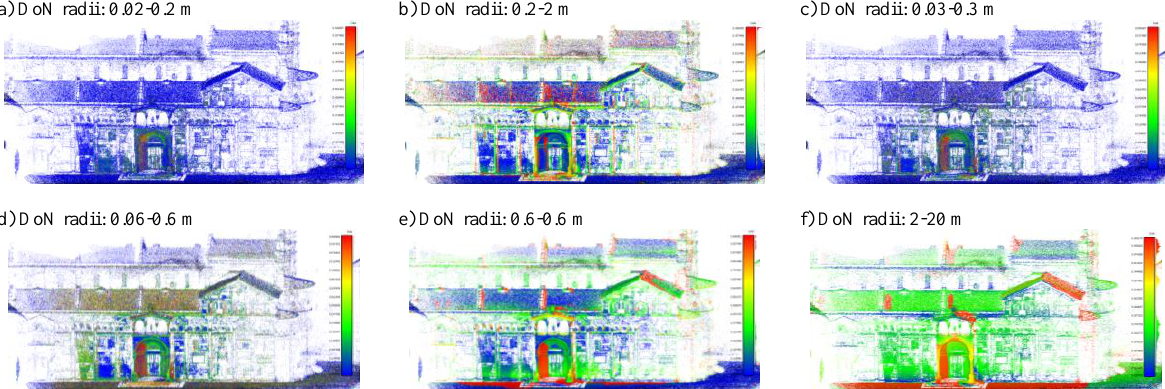
Figure 5: Vector magnitude of the Difference of Normals (DoN) operator using several combination of radii. The DoN operator produces high response in areas with significative surface changes in the given radii range. For small radii values (i.e. case – b ), greater variations are expected in fine-detailed areas. Increasing the radii values (i.e. case - f ), DoN detects higher changes in the large architectonical parts (roof, façade,..).